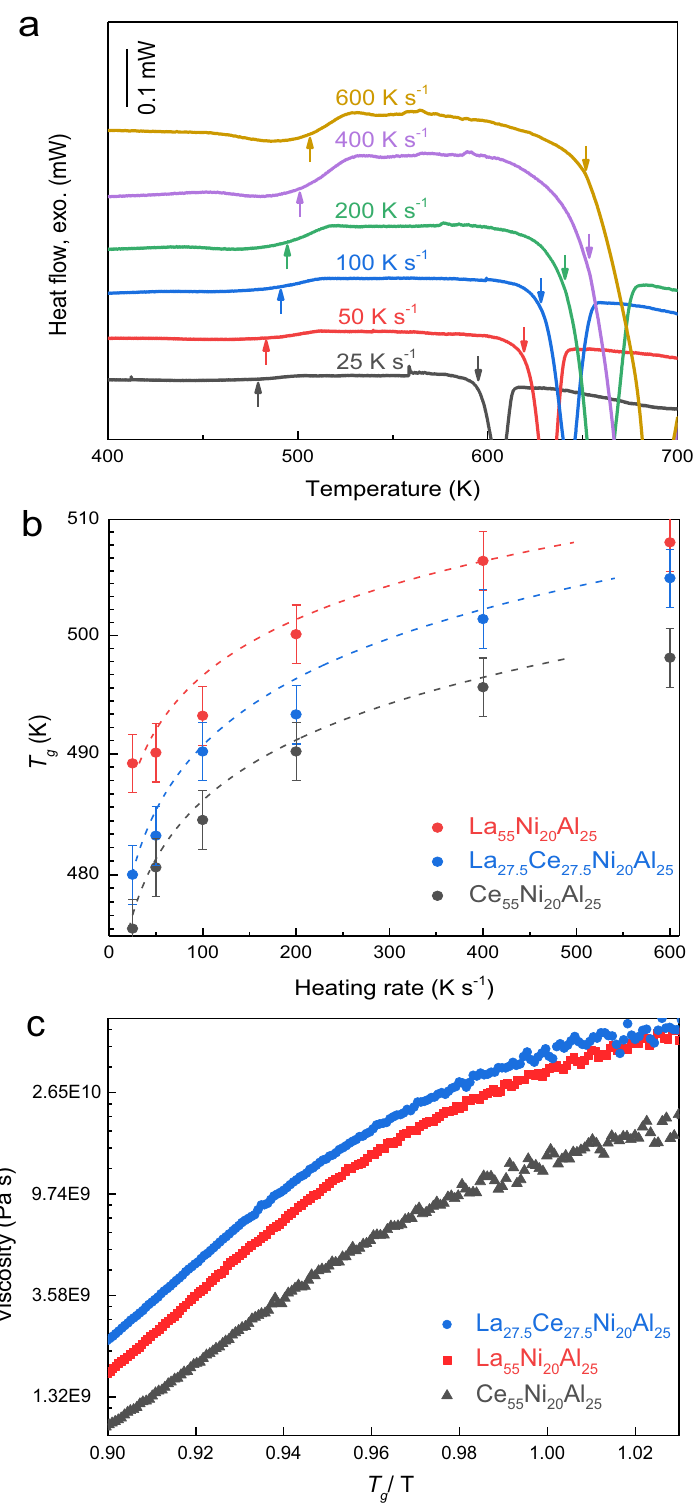
Fig. 2 The fragility and viscosity behaviors of the La(Ce)NiAl system. a DSC traces of LaCe-HEMG with heating rates ranging from 25 to 600 K s − 1 . The left- and right-side arrows indicate T g and T x , respectively. b Heating rate dependence of T g for the La(Ce)NiAl MGs system and the corresponding VFT fi tting traces (dashed lines). The error bars were obtained by standard deviation from three measurements of T g on a DSC curve. c Nonequilibrium viscosity near the glass-transition region for the La(Ce)NiAl MGs, obtaining at a constant heating rate of 0.33 K s − 1